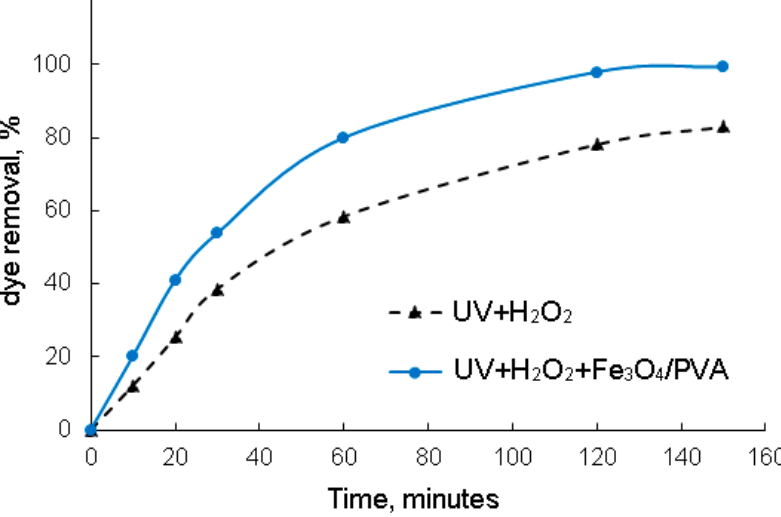
Figure 7. Evaluation of the photodegradation process as a function of the reaction time, at pH of 3 and initial dye concentration of 5 × 10 − 4 mol·L − 1